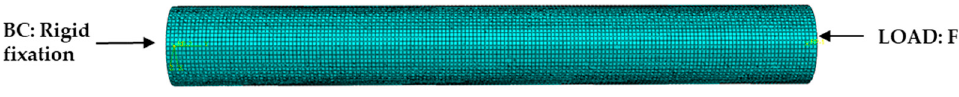
Figure 5. Load application and boundary conditions.